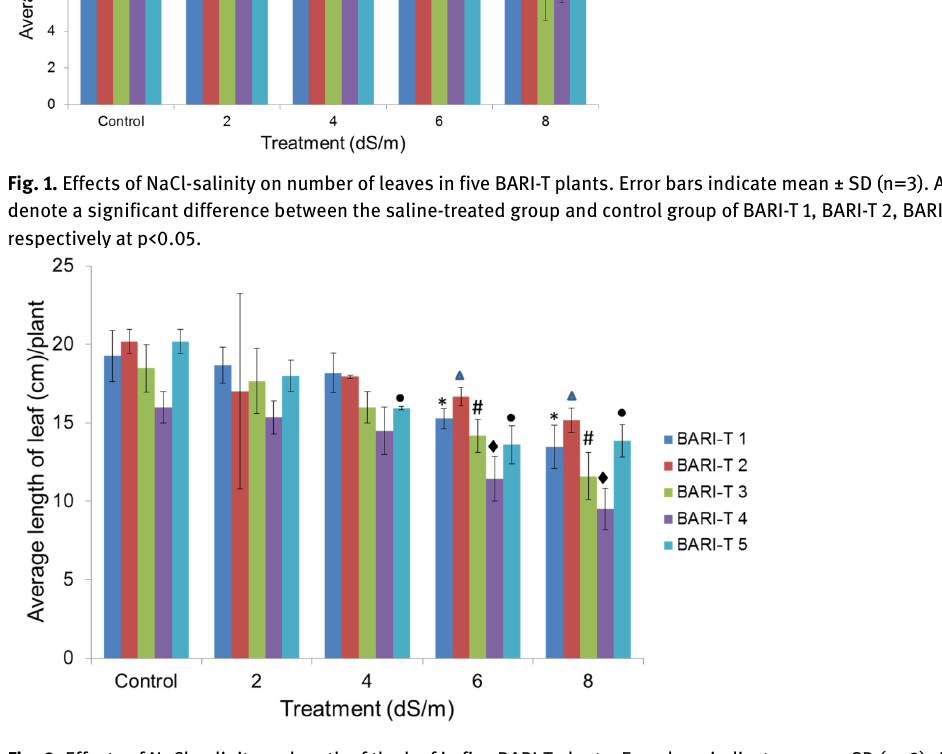
Fig. 2. Effects of NaCl-salinity on length of the leaf in five BARI-T plants. Error bars indicate mean ± SD (n=3). Asterisk *, , #, ♦ , and • denote a significant difference between the saline-treated group and control group of BARI-T 1, BARI-T 2, BARI-T3, BARI-T 4 and BARI-T 5, respectively at p<0.05.